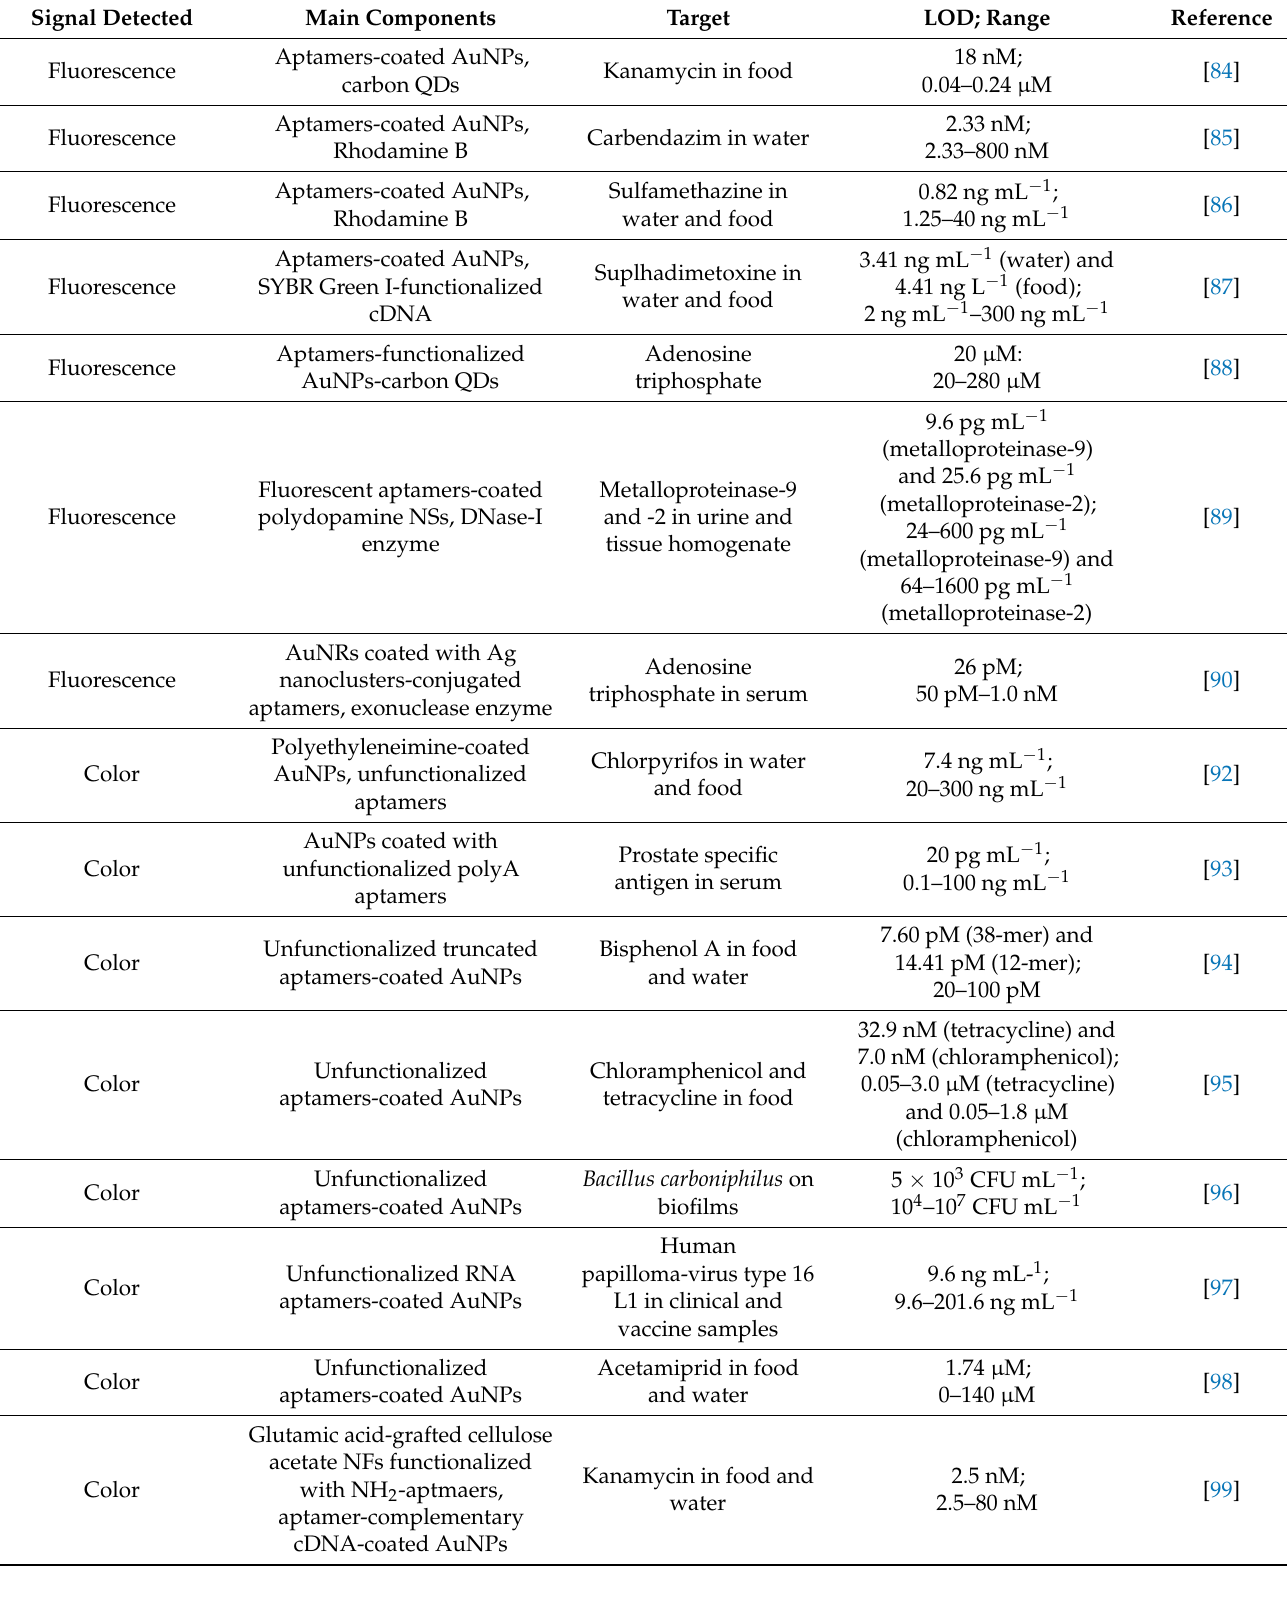
Table 3. Optical aptasensors cited in this